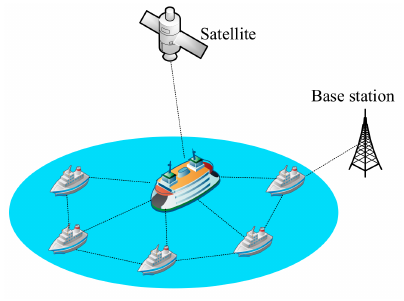
Figure 6. Structure diagram of SANET.